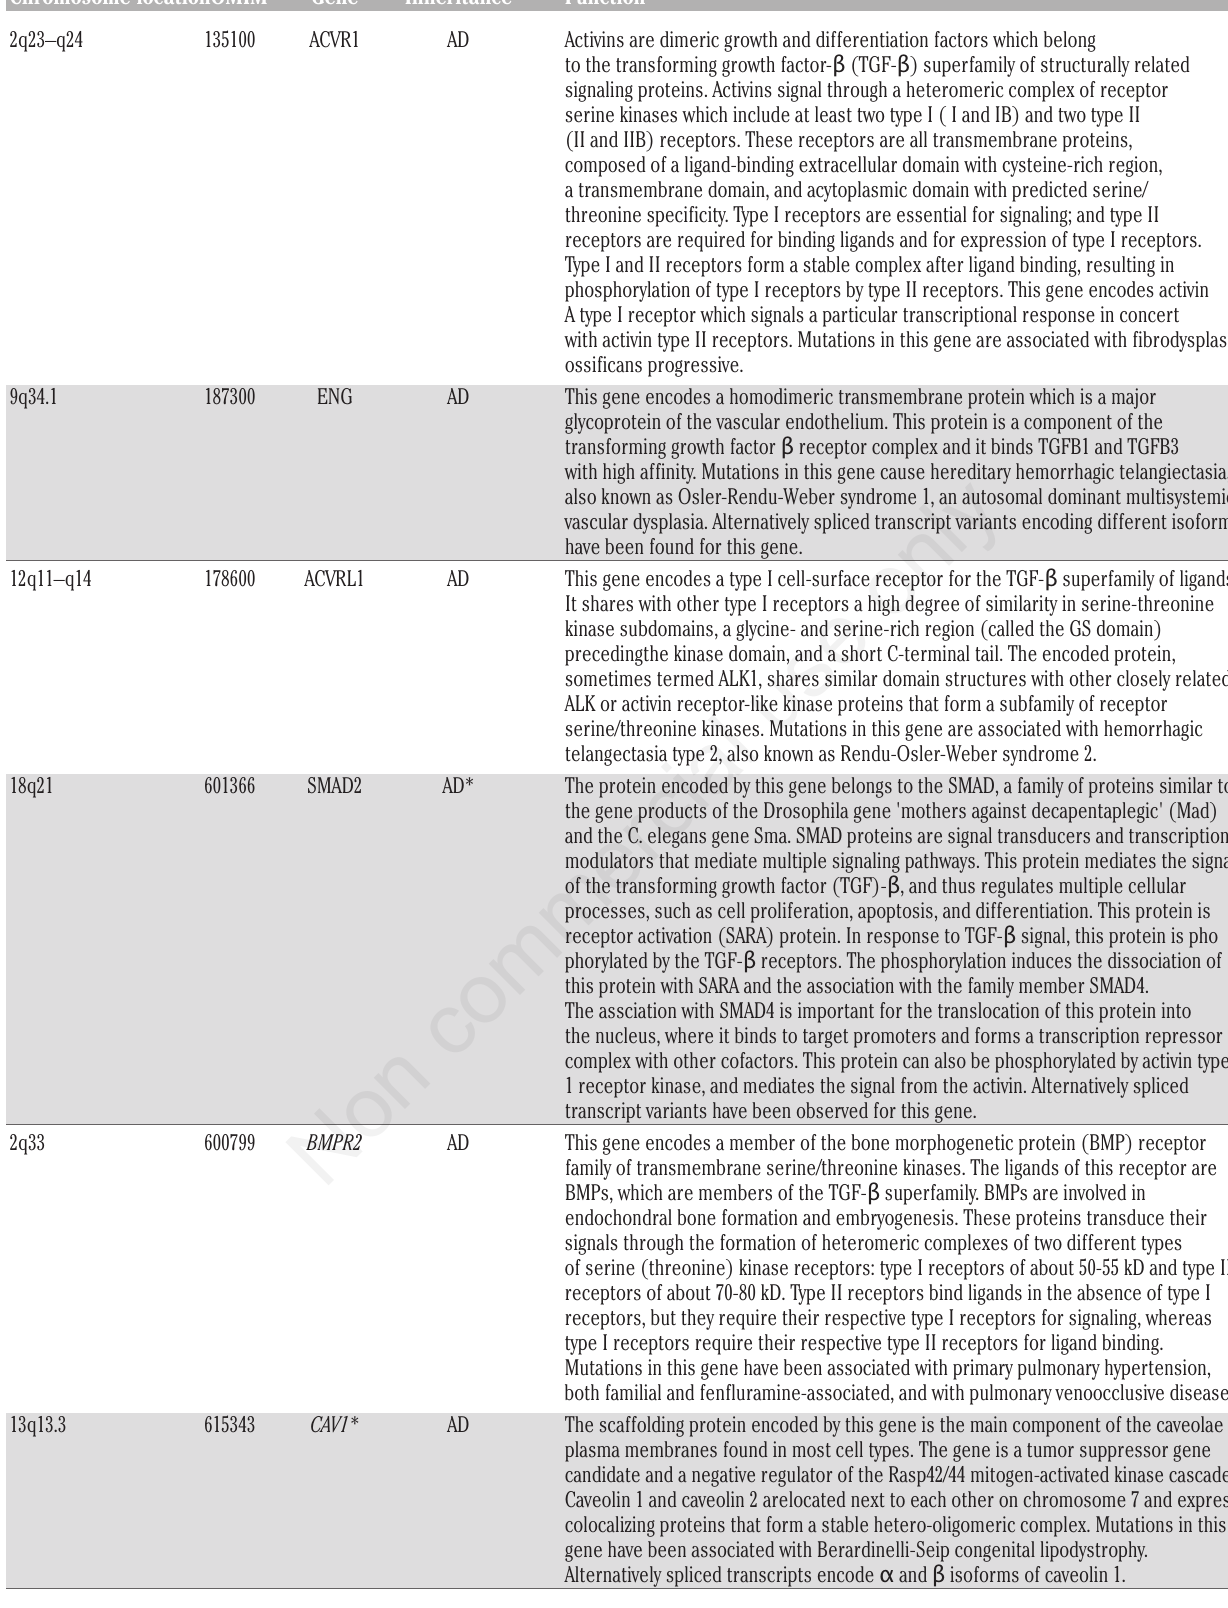
Table 2. Characteristics of genes currently associated with the onset of idiopathic pulmonary arterial hypertension. Chromosome